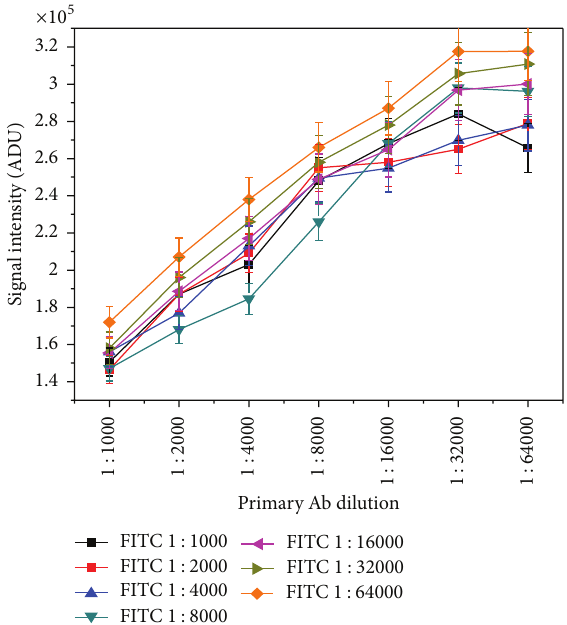
Figure 3: Optimization curve of FITC labeled 2 ∘ Ab against 1 ∘ Ab.